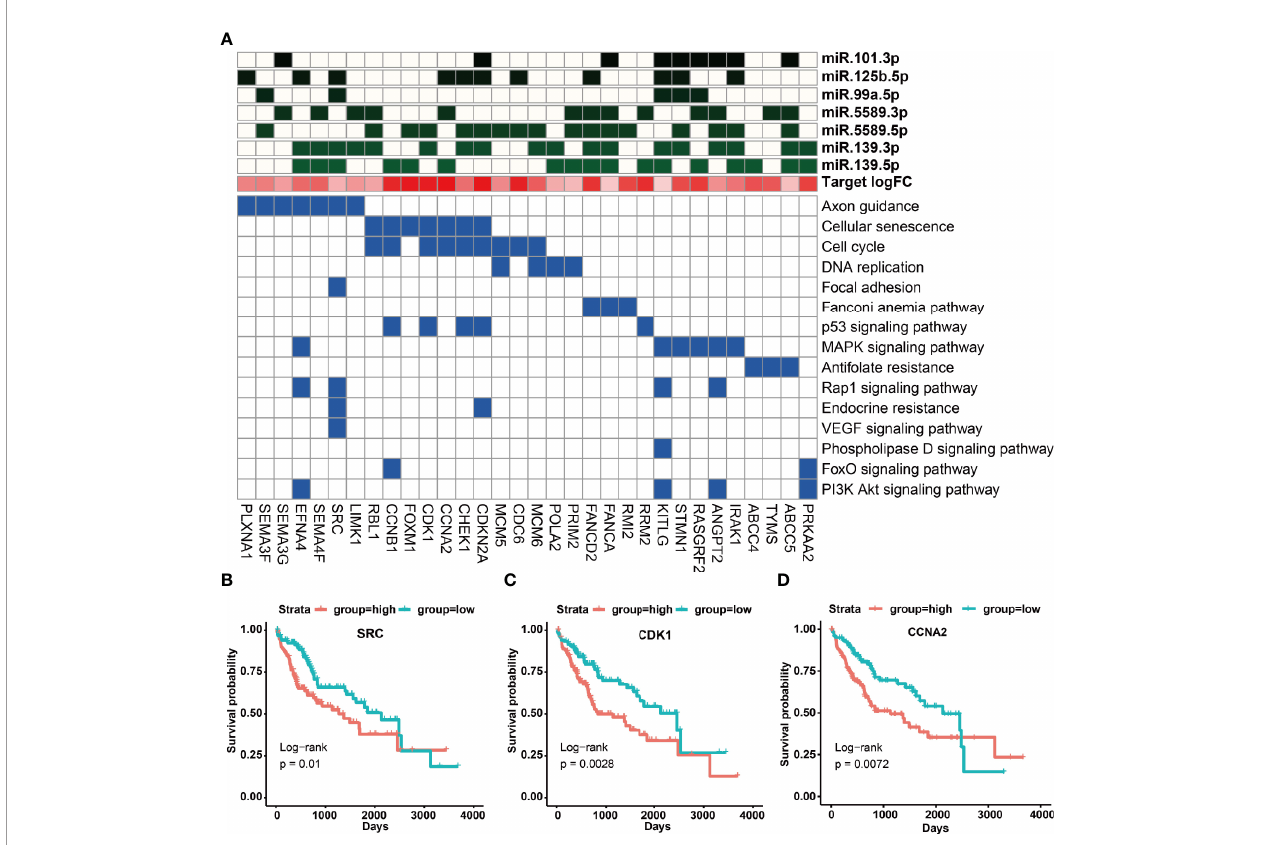
FIGURE 4 | KEGG signaling pathways of up-regulated target genes and their regulation by miRNAs. (A) KEGG signaling pathways involved in survival-related up- regulated target genes and their regulation by miRNAs. (B – D) The impact of up-regulated target genes on the overall survival rate of HCC patients, taking SRC, CDK1 and CCNA2 as